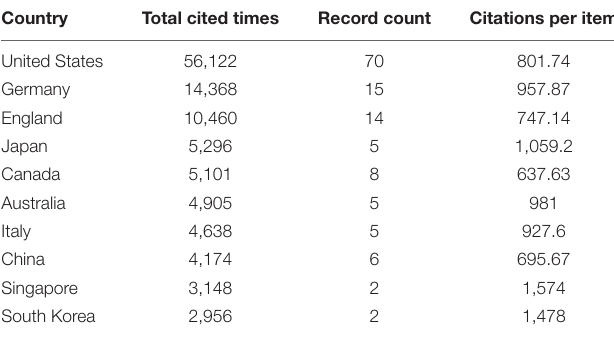
TABLE 1 | List of the top 10 cited countries.